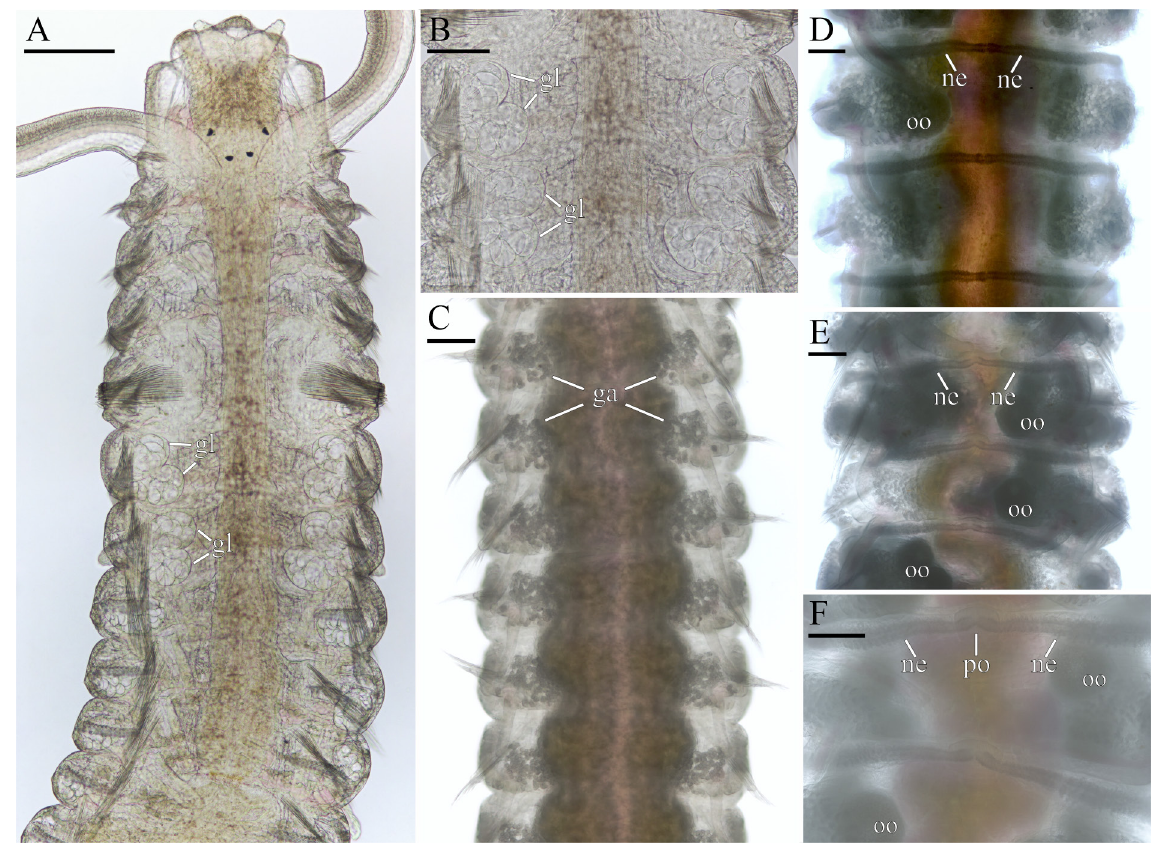
Fig. 7. Adult morphology of Pseudopolydora antennata (Claparède, 1868) (live individuals). A–B . MIMB 40895. C–D . MIMB 40897. E–F . MIMB 40899. A . Anterior end, semi-pressed, dorsal view, showing arrangement of glandular pouches in neuropodia. B . Chaetigers 6–7, semi-squashed, dorsal view, showing double glandular pouches in each neuropodium. C . Middle chaetigers, dorsal view, showing paired gatherings of glandular cells on the dorsum. D–F . Female fertile chaetigers, dorsal view, showing distal parts of paired nephridia opening to a common middorsal nephridiopore on each chaetiger. Abbreviations: ga = gatherings of glandular cells; gl = glandular pouches in neuropodia; ne = nephridia in female fertile chaetigers; oo = oocytes; po = nephridiopore. Scale bars: A = 200 µm; B–F = 100